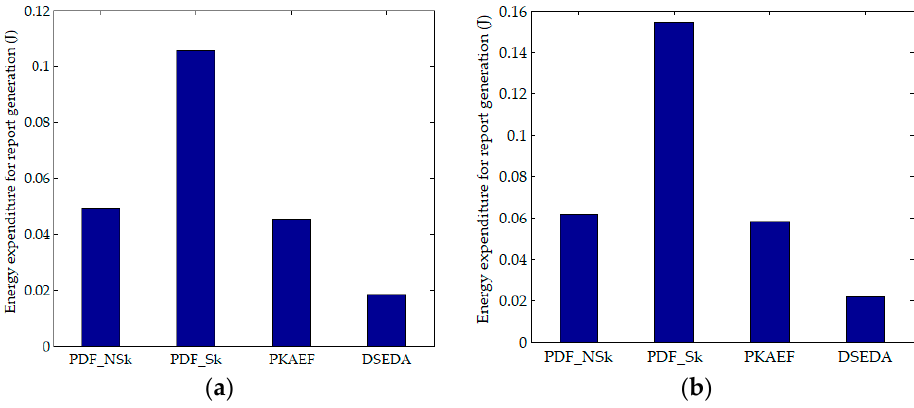
Figure 2. Energy expenditure for report generation. ( a ) in Scenario 1; ( b ) in Scenario 2.